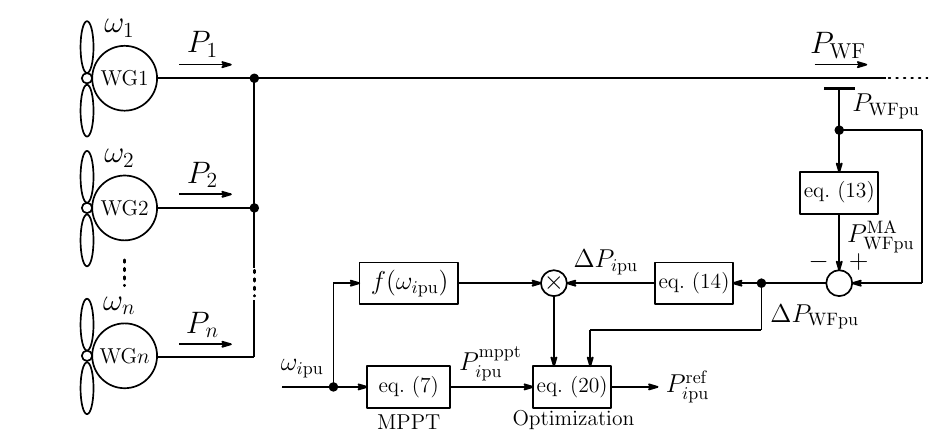
Figure 5. Optimal kinetic energy control.